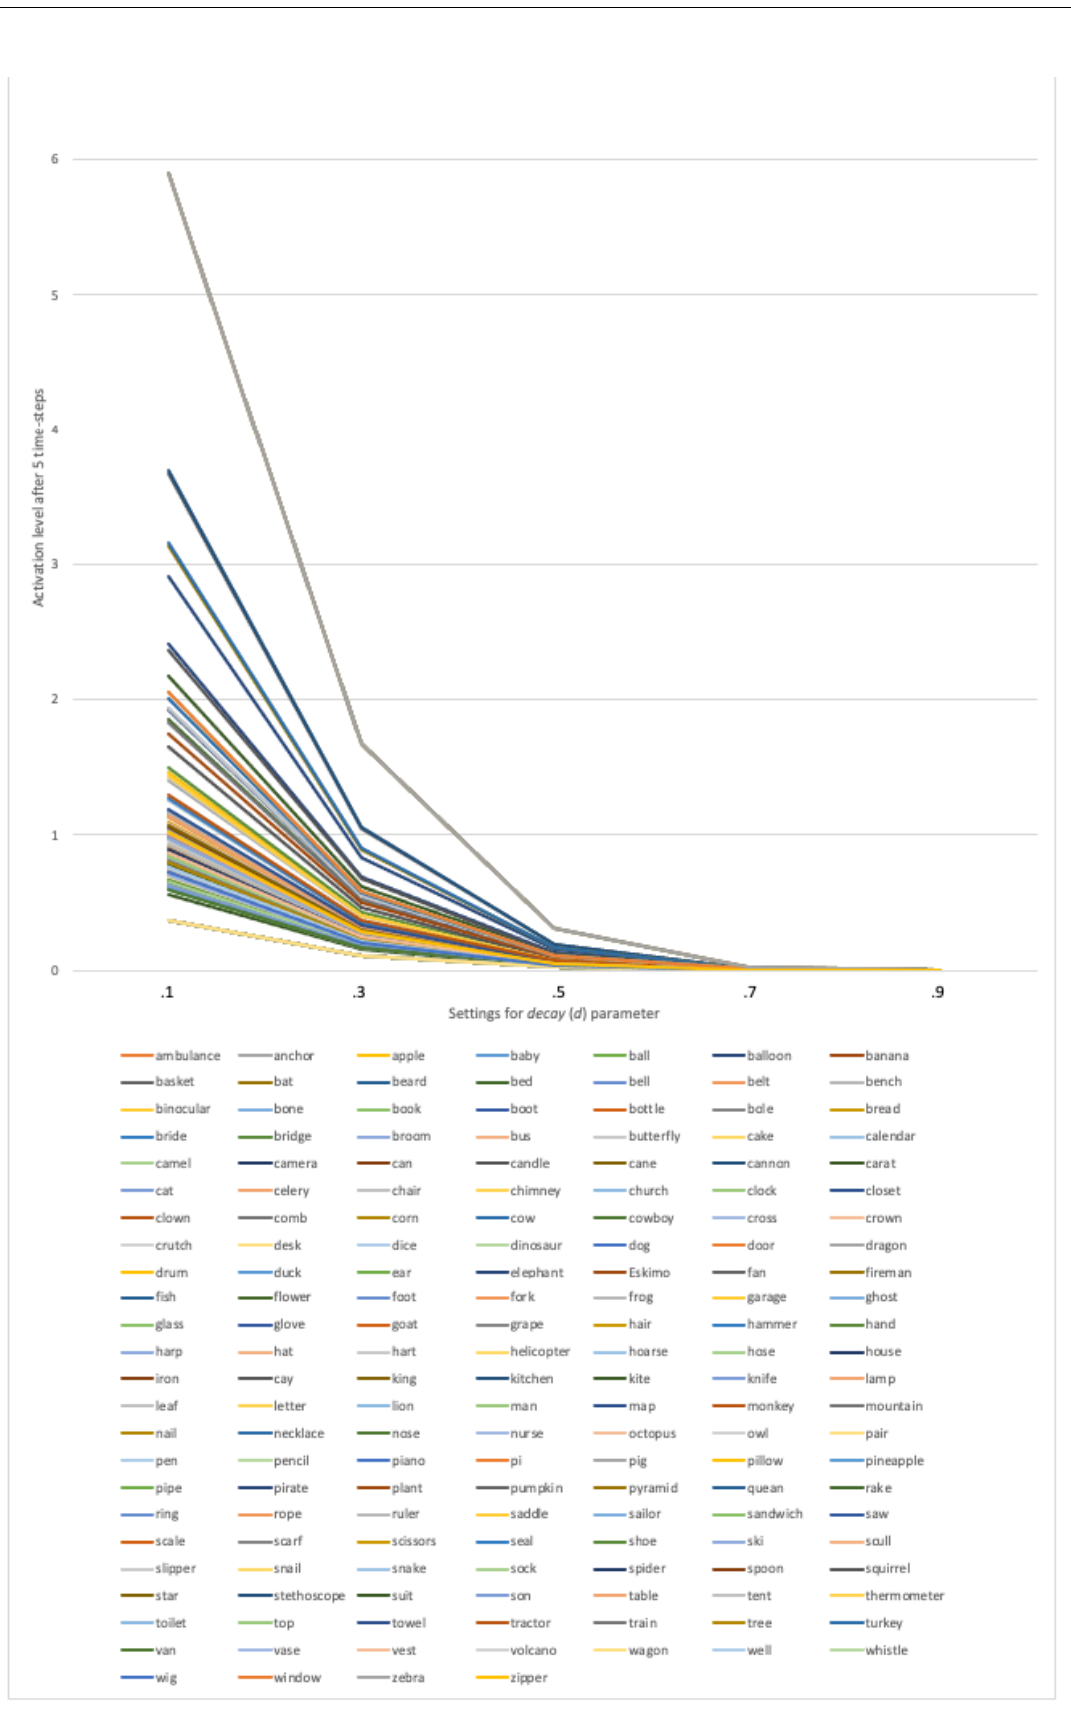
Figure 6. The activation level after five time-steps for each word from the PNT at each setting of the decay ( d ) parameter.